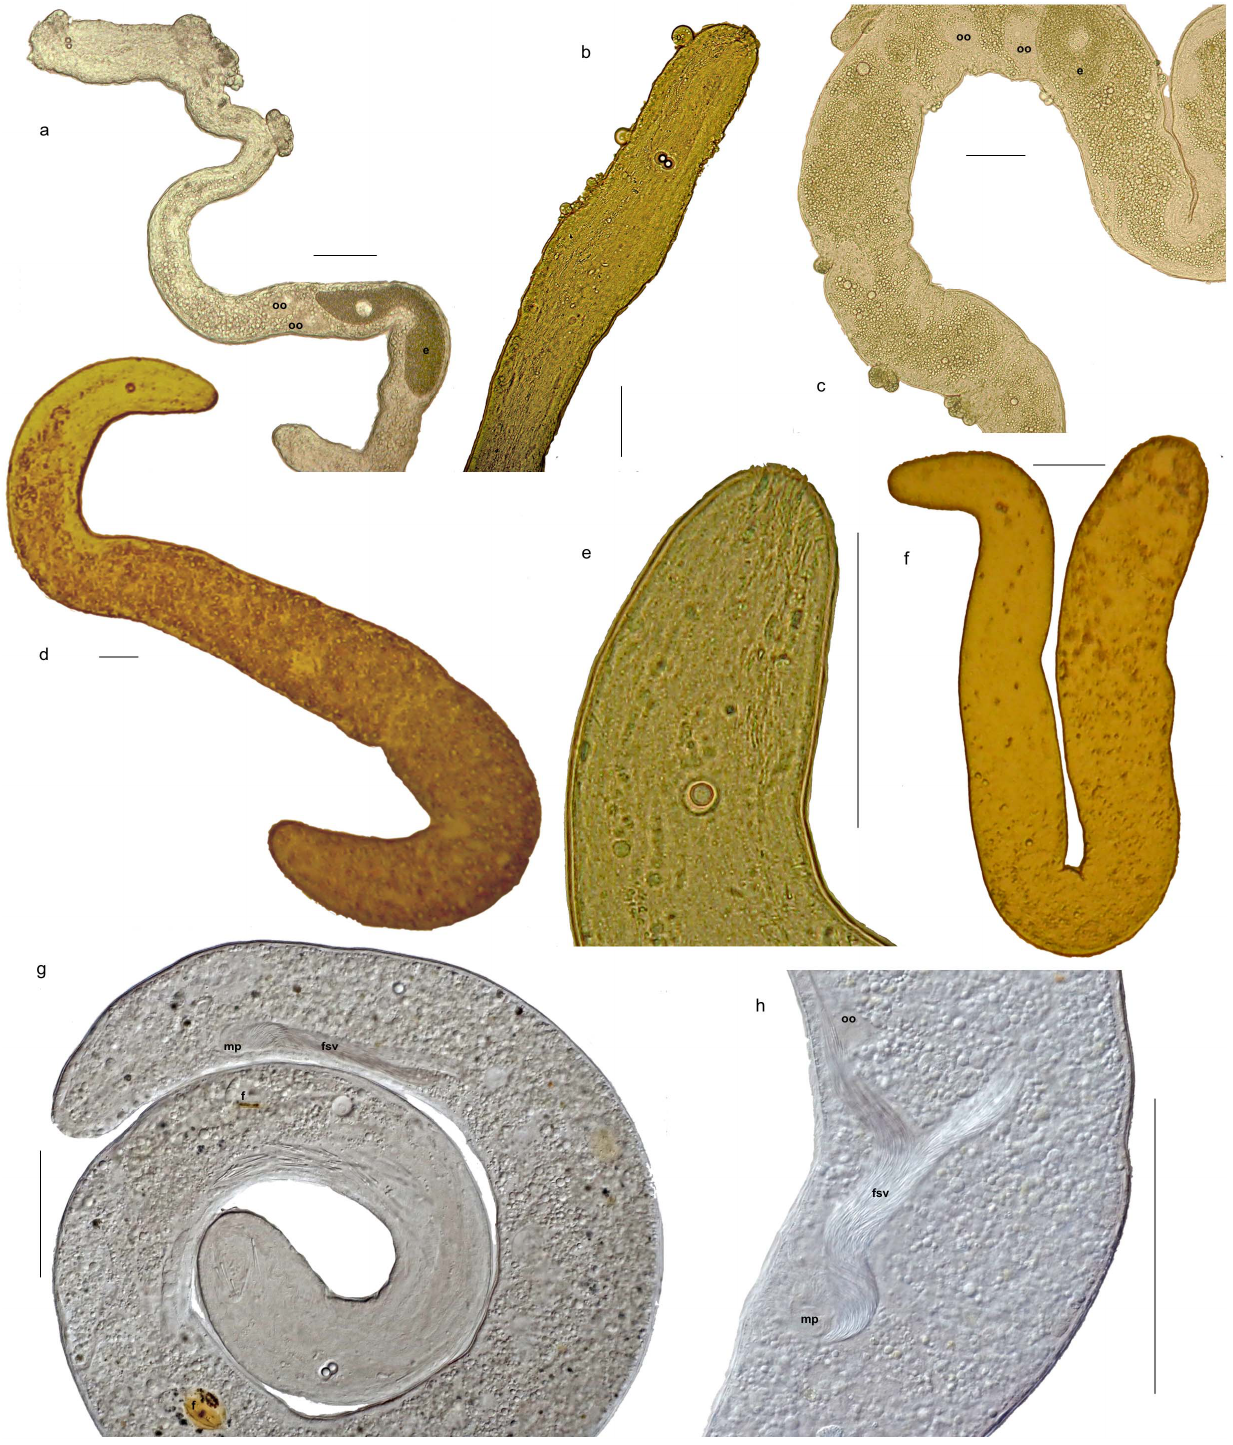
Figure 8. Diversity within the genus Sterreria . a: Sterreria martindalei n.sp. Overview over slightly damaged specimen with mature egg (e) and oocytes in the posterior. b, c: Sterreria ylvae n.sp. b) Anterior part with statocyst with double statoliths. c) Mid-section of the body with one mature egg (e) and few oocytes (oo). d, e: Sterreria monolithes n.sp. d) Overview over immature animal with only one statolith in the statocyst. e) Detail of the anterior of the same specimen with fanning out frontal gland opening and frontal gland secretions. The single statolith fills nearly the whole statocyst. f: Sterreria boucheti n.sp. Overview over complete, immature specimen. g, h: Sterreria variabilis n.sp. g) Overview over male mature specimens with club-shaped frontal gland secretions and food particles (f) in gut. h) Detail of male copulatory organ with fsv anterior of male pore (mp) and oocyte (oo). All photographs were taken of the live holotype specimens in squeeze preparation. The scale bars indicate 100 m m for each photograph.